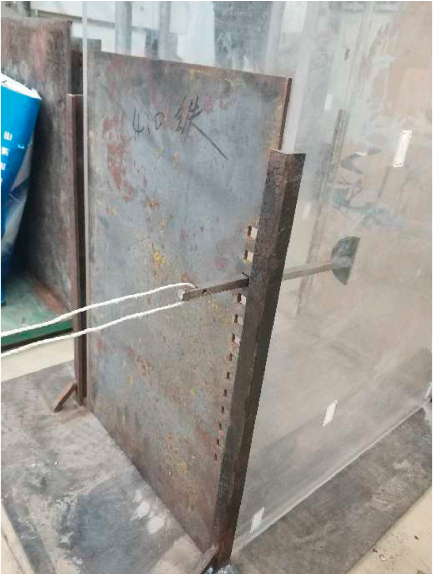
Figure 2: Detailed test model equipment.